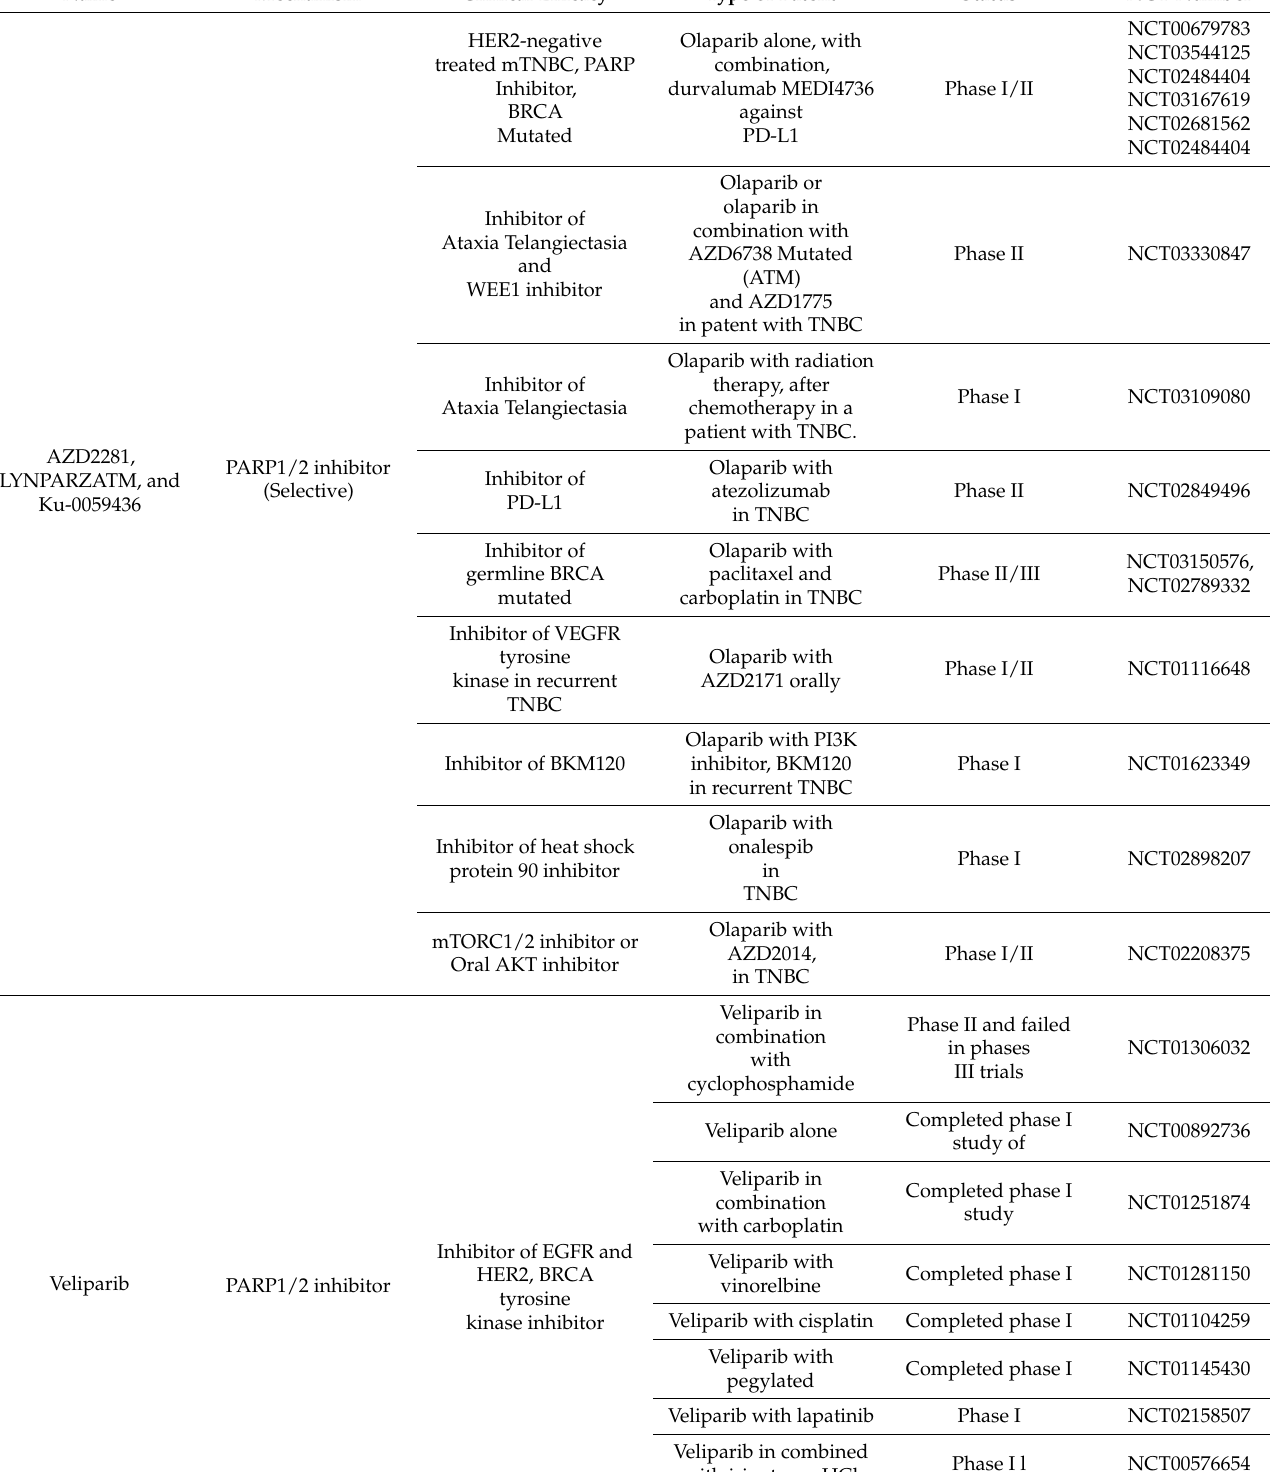
Table 1. Structures and efficacy of PARP inhibitors currently under clinical evaluation for